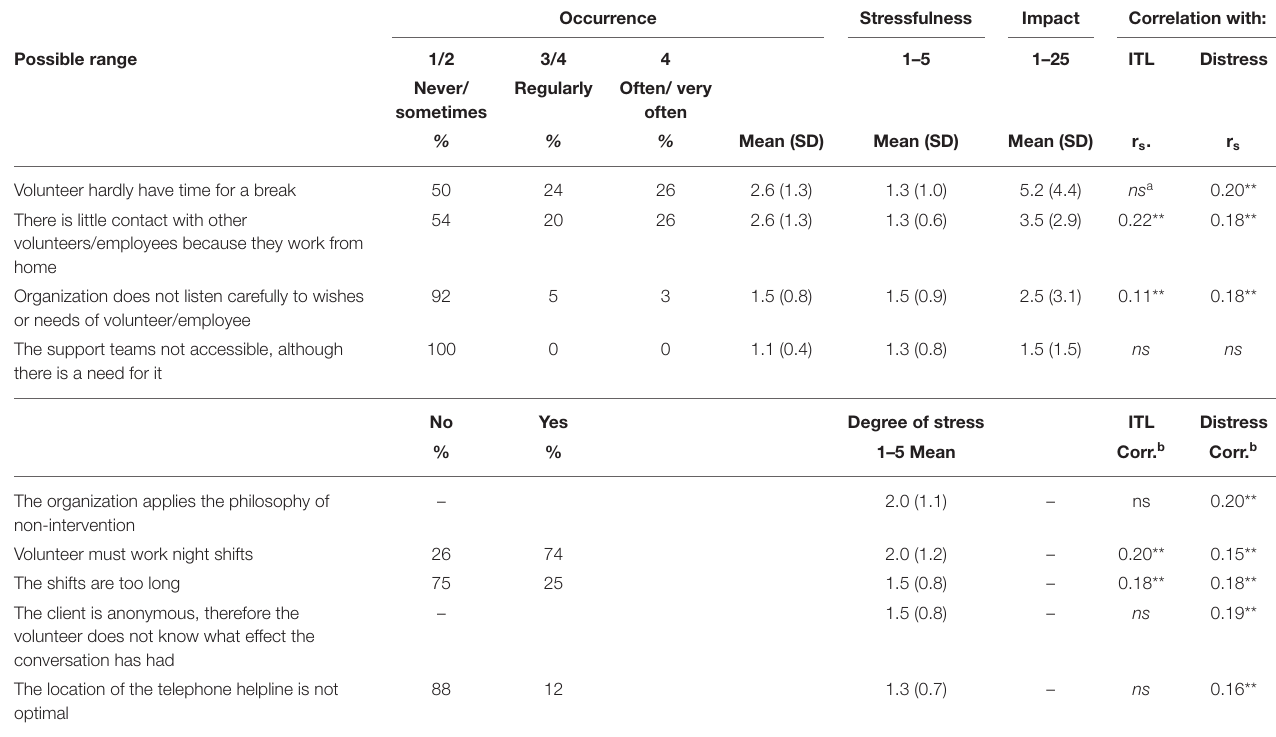
TABLE 3 | Summary of descriptive statistics organization-related demands: frequency, degree of stress, and impact (product frequency and degree of stress)* and Spearman’s rho correlations with Intention to Leave (ITL) and Distress ( N =